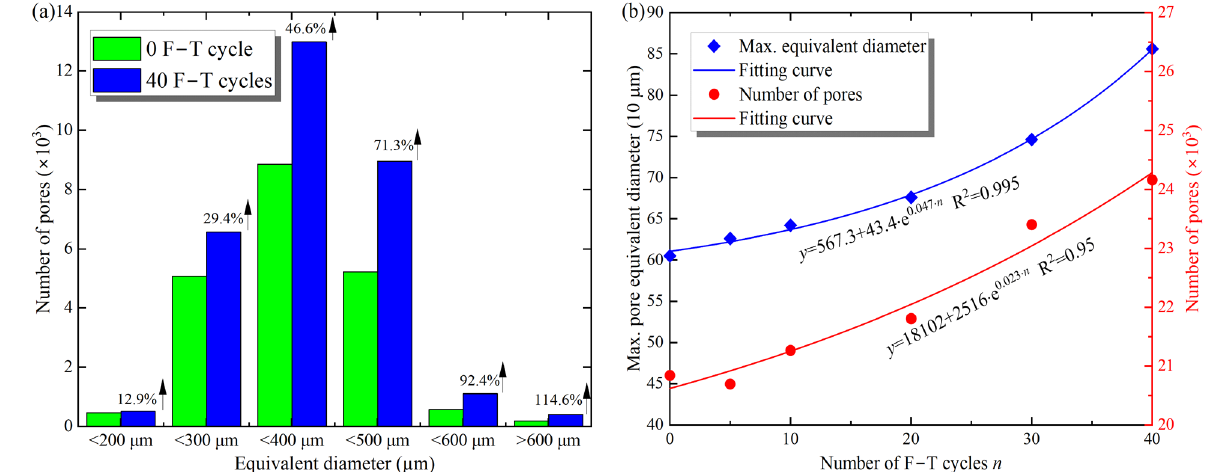
Figure 9. Distribution of the pore equivalent diameters ( a ) and the maximum and total number of pores ( b ) with F–T cycles.